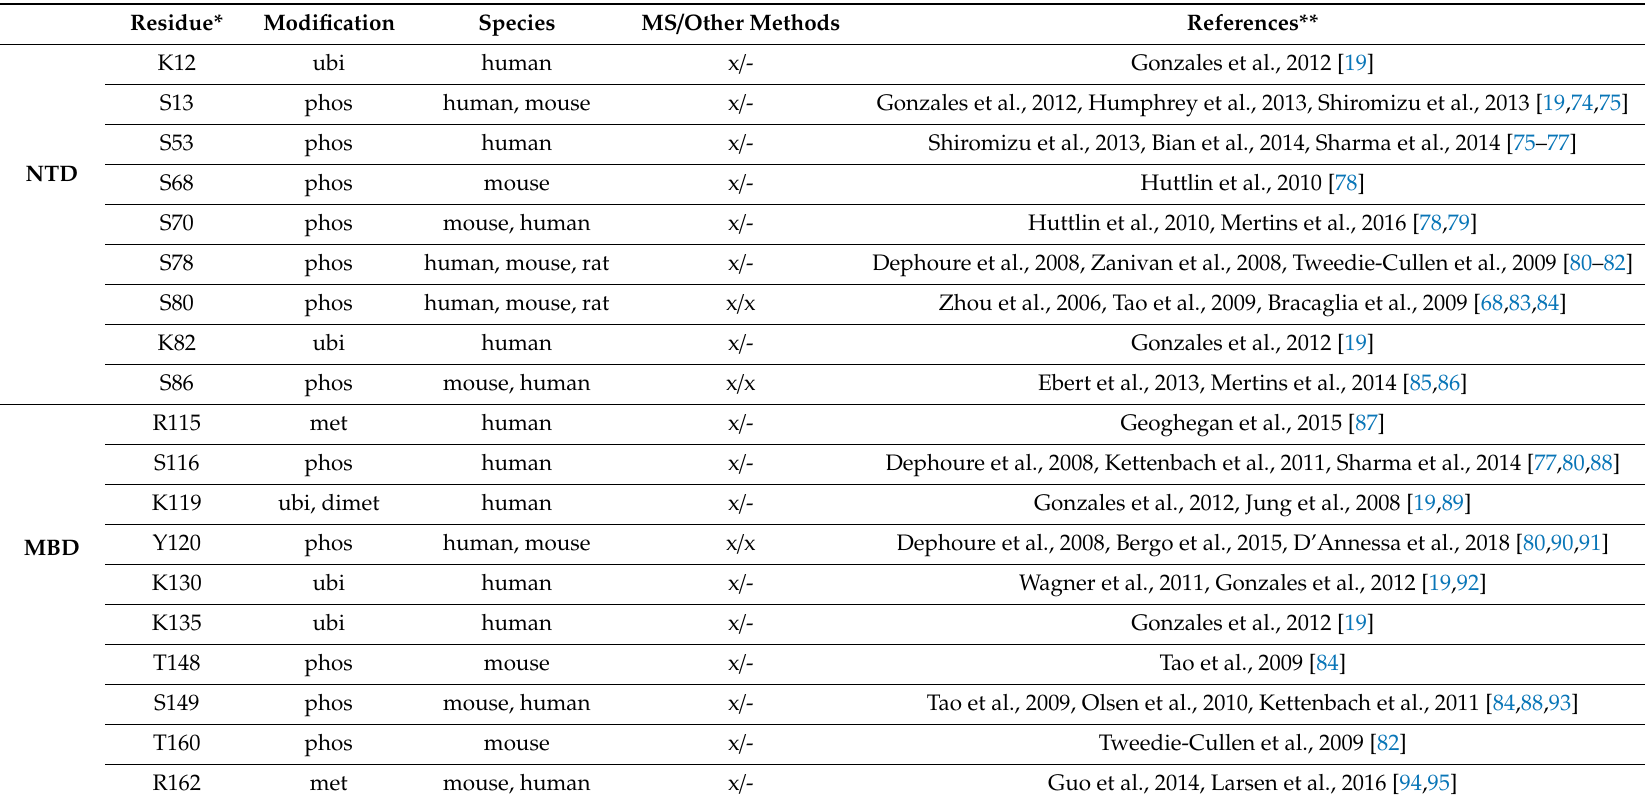
Table 2. Summary of MeCP2 post-translational